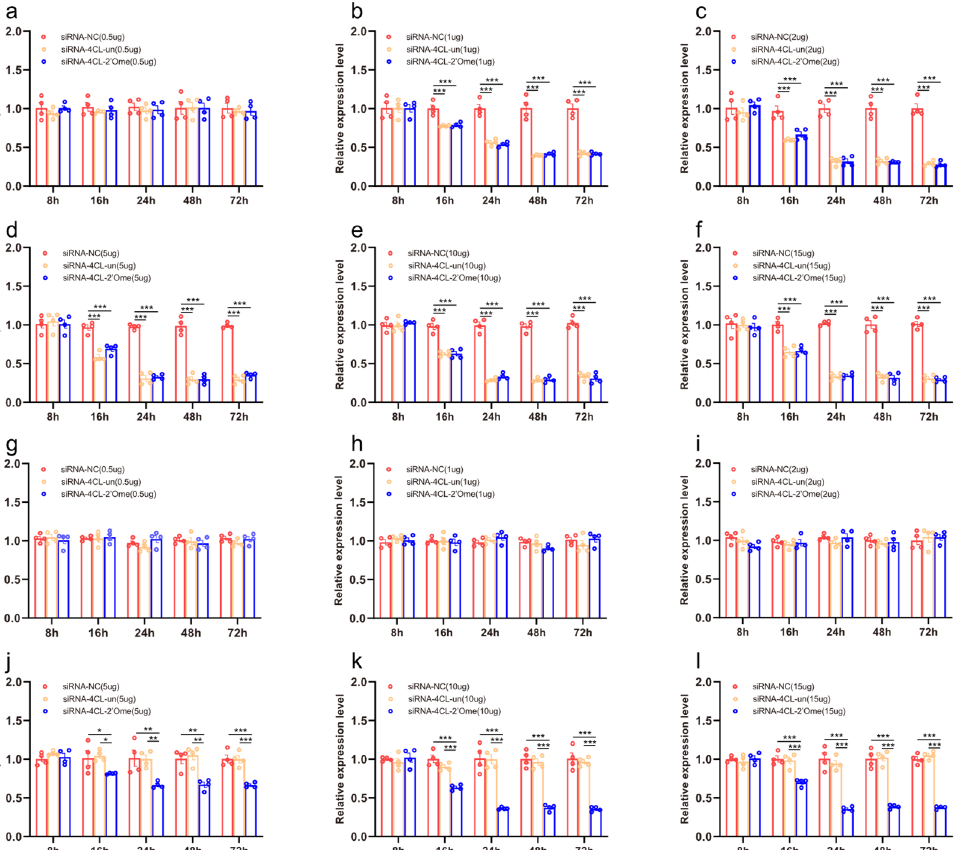
Figure 3. The effects of siRNA on 4CL mRNA transcripts in honey bee brains. The mRNA levels of 4CL were analyzed at 8 h, 16 h, 24 h, 48 h, and 72 h after injection of 0.5 μ g ( a ), 1 μ g ( b ), 2 μ g ( c ), 5 μ g ( d ), 10 μ g ( e ), and 15 μ g ( f ) siRNA, or after feeding of 0.5 μ g ( g ), 1 μ g ( h ), 2 μ g ( i ), 5 μ g ( j ), 10 μ g ( k ), and 15 μ g ( l ) siRNA. The red column shows the relative expression of siRNA-NC injected. The orange column shows the relative expression of siRNA-4CL-un injected. The blue column shows the relative expression of siRNA-4CL-2 ′ Ome injected. Each circle represents a biological repeat. * Indicates p < 0.05, ** indicates p < 0.01, *** indicates p < 0.001, tested by ANOVA test. Detailed data are shown in Table S3.